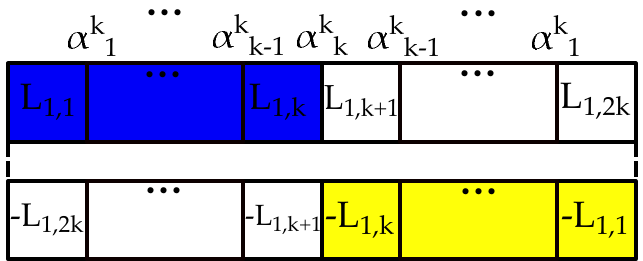
Figure 12. We show the box graph for the (cid:13)avor-equivalence class of Sp( N ) with k = N a hyper- multiplets transforming in the anti-symmetric representation. The boxes whose decoration is (cid:12)xed by (3.33) are colored. All consistent colorings of the remaining boxes give rise to all consistent (cid:13)avor-equivalence classes of this theory. Since the structure of the (cid:13)avor-equivalence box graph is dependent on the Sp(2 N a ) symmetry rotating the N a hypermultiplets, and not on the particular highest and lowest weights of the anti-symmetric representation of the Sp( N ) but only that they are conjugate, the same structure exists for all theories that have a sympletic symmetry group that acts as rotations on hypermultiplets that transform in a self-conjugate representation of the gauge group. This includes the SO( N ), G 2 , and F 4 theories of interest in this